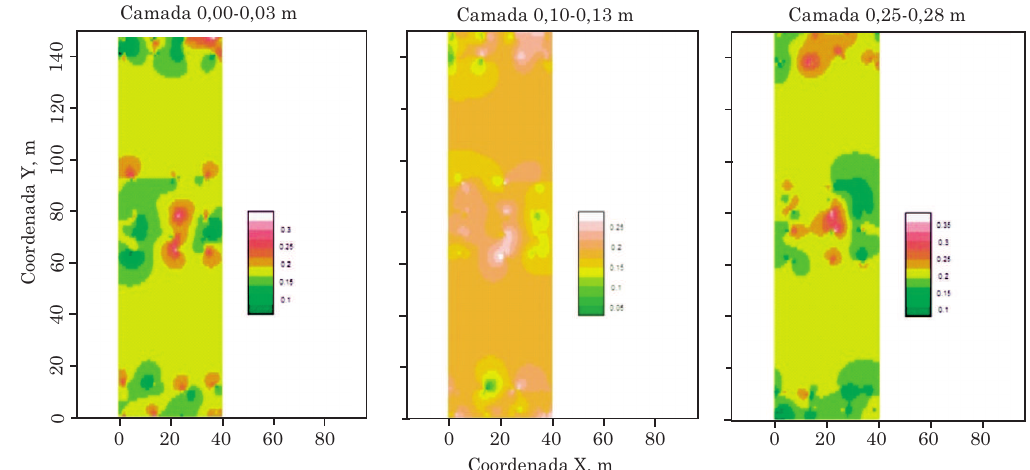
Figura 3. Mapa da distribuição espacial da macroporosidade do solo na área de estudo.